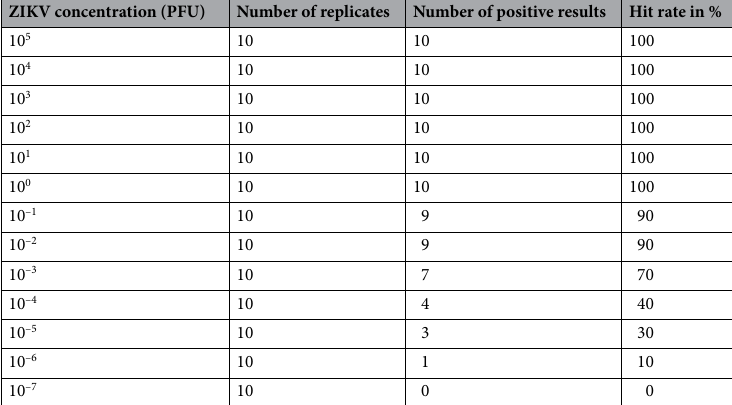
ZIKV concentration (PFU) Number of replicates Number of positive results Hit rate in % 10 5